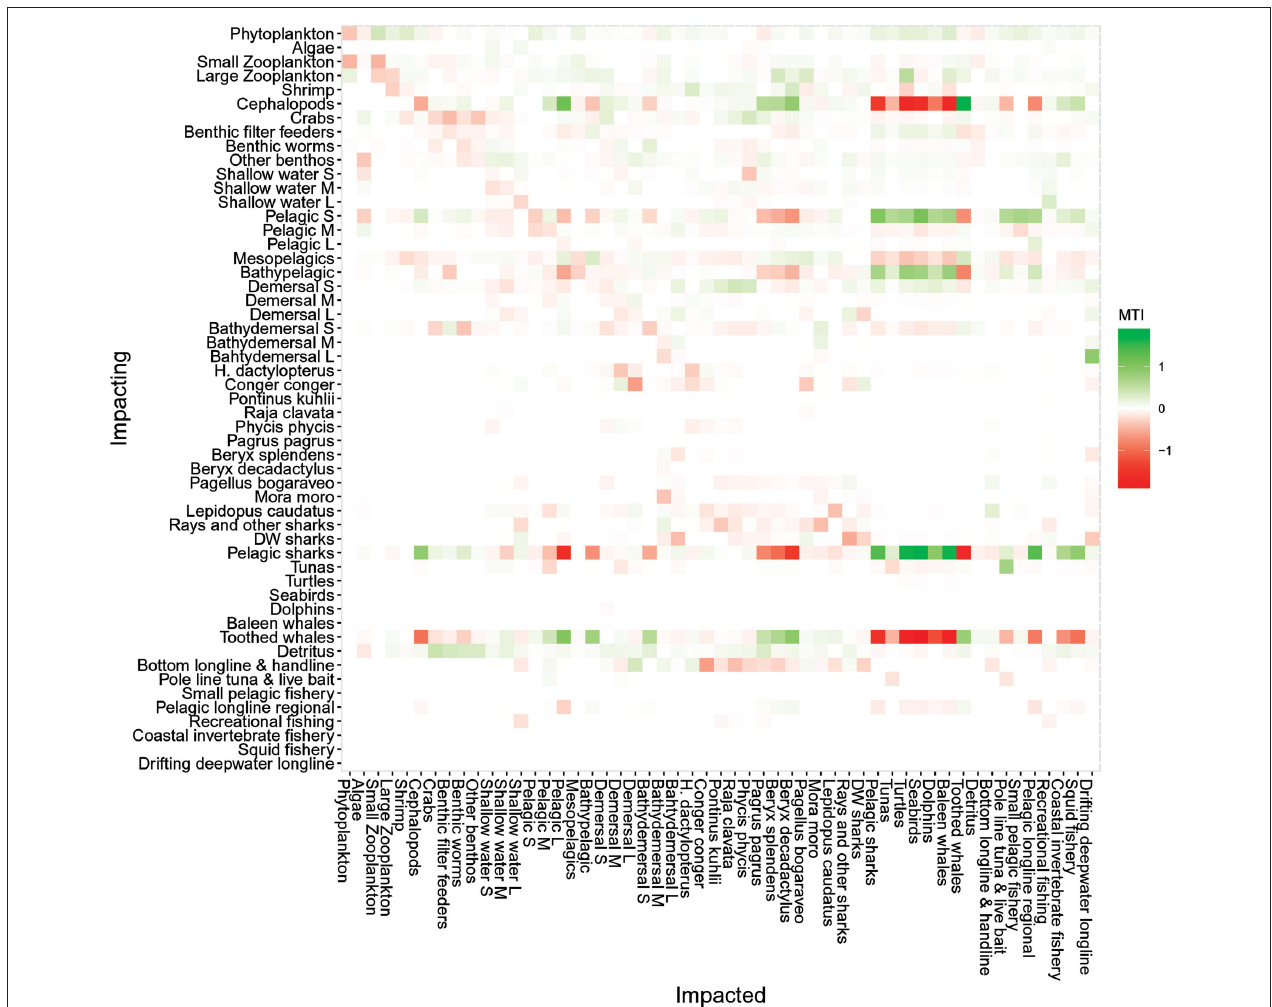
FIGURE 7 | Mixed trophic impact analysis of the Azores ecosystem model for the reference year 1997. The figure shows positive (green), negative (red), or no (white) impacts. Impacting groups are shown on the vertical axis, and impacted groups on the horizontal axis. S, small-size; M, medium-size; L, large-size; DW,